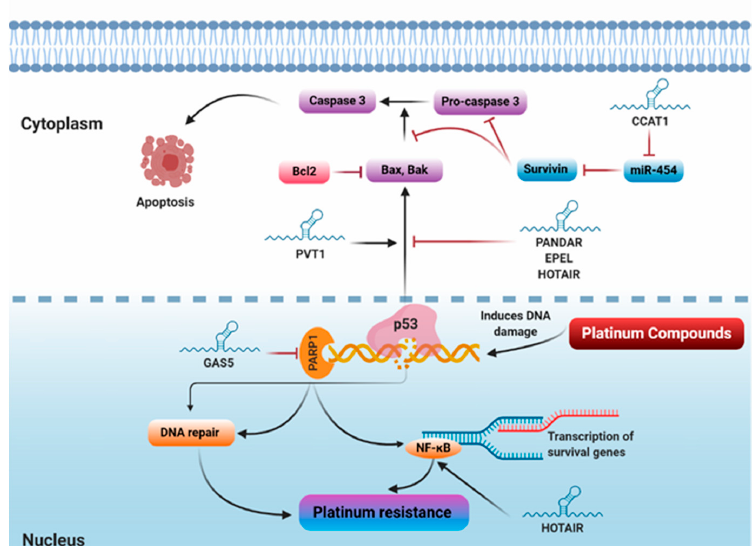
Figure 4. lncRNAs regulate platinum resistance via modulating DNA-damage-induced apoptosis.